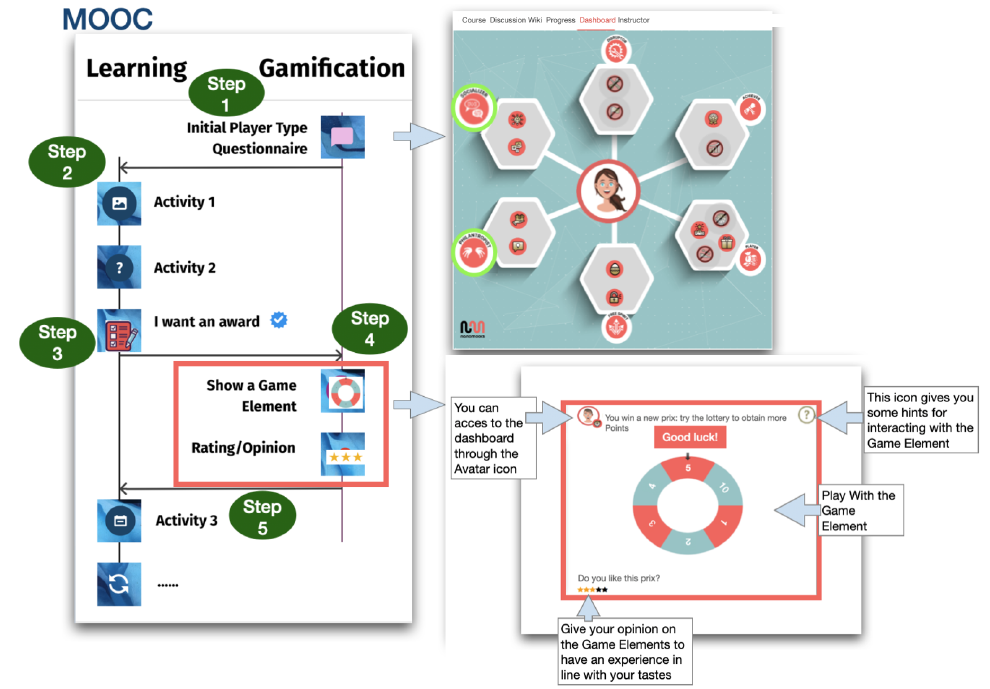
Figure 3. Gamified MOOC structure: on the left, the learning itinerary, on the right the embedded gamification in the MOOC (the dashboard and the game elements). See videos. See more details in: the initial Player Type Questionnaire, the Dashboard, and the Gamification Element Widgets, accessed on 12 January